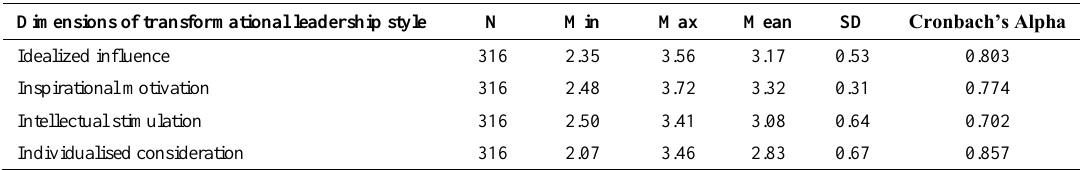
Table 4. The status of transformational leadership style.